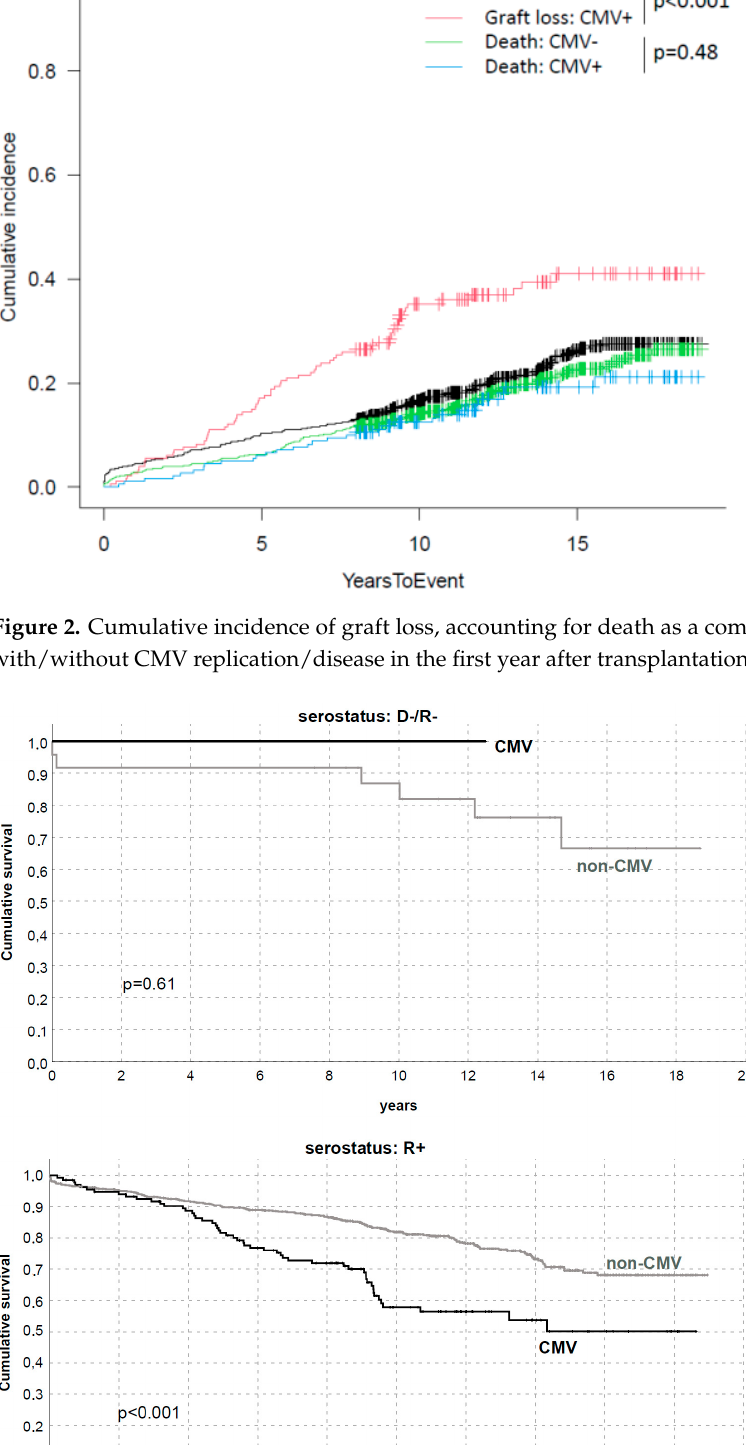
Figure 1. Death-censored graft survival by CMV replication/disease in the first year after transplantation.